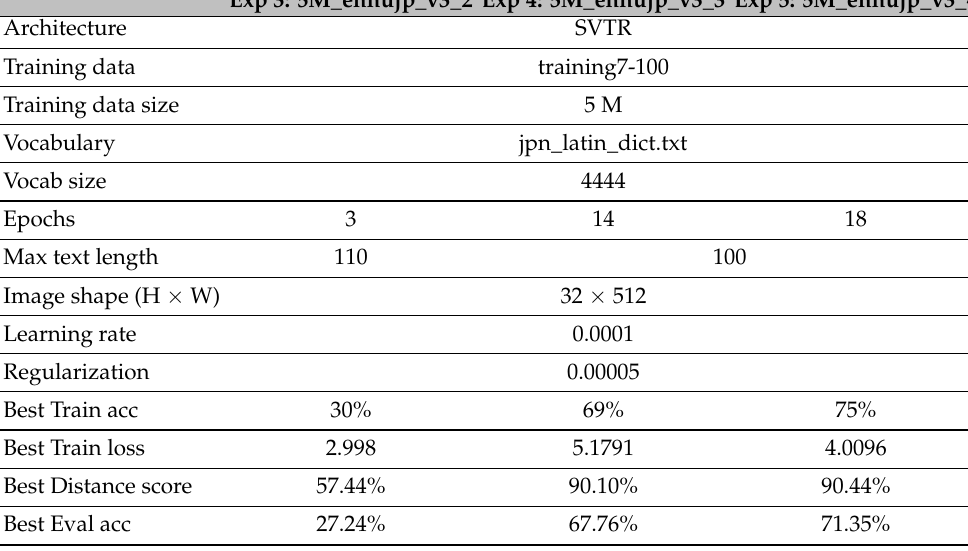
Table 10. Multilanguage Experiments: 3, 4, and